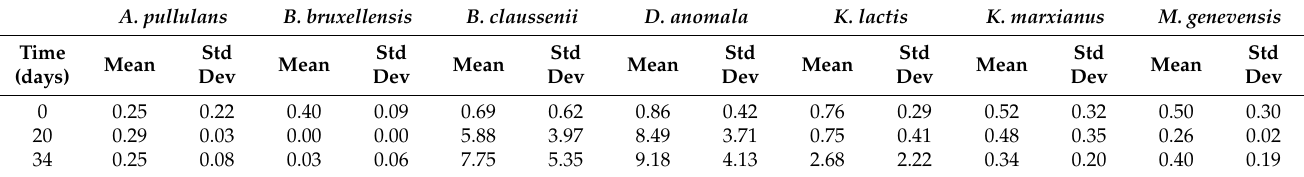
Table 6. Acetic acid concentrations under aerobic fermentation (g/L).